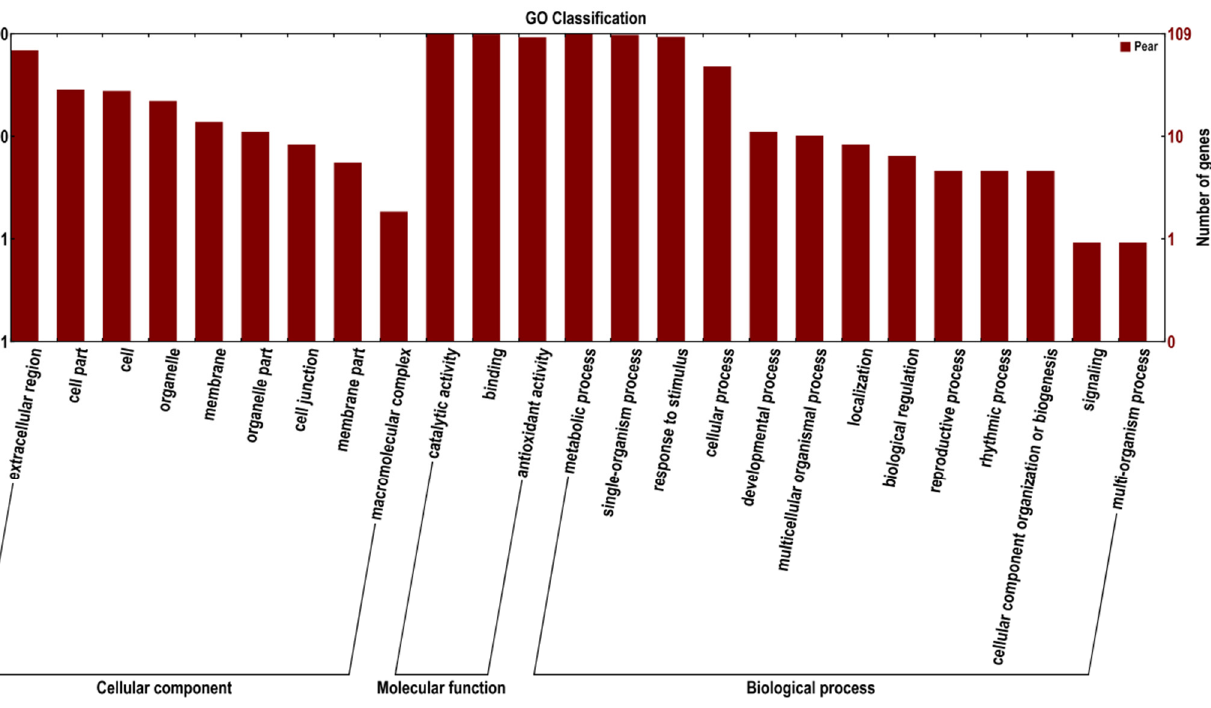
Figure 3. GO categories of the genes identified. Y-axis ( left ) represents percentages of genes identified in this study, Y-axis ( right ) represents the actual gene number. The genes were annotated in three main categories: biological process, cellular component, and molecular function (X-axis).